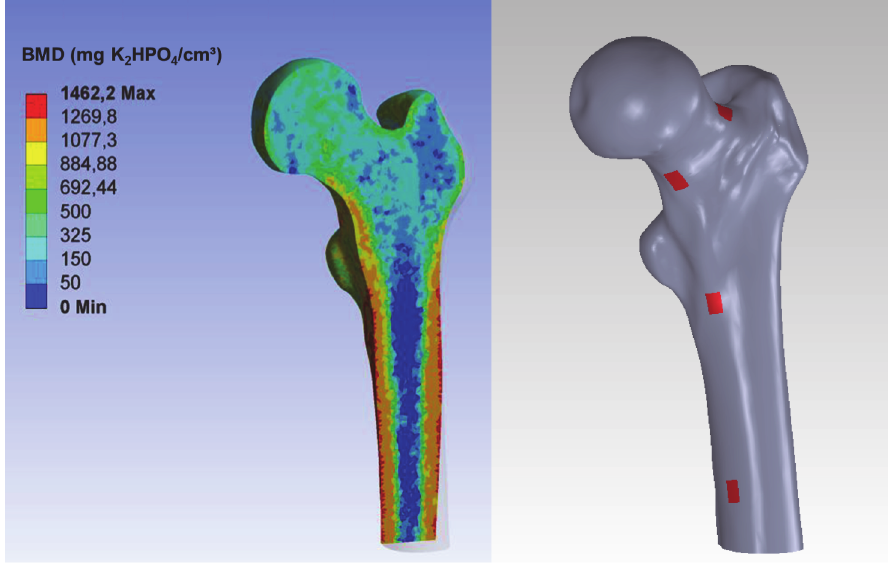
Fig 2. Representation of the bone mineral density distribution within the bone (left) and location of the string gauges at the femur specimen (right).